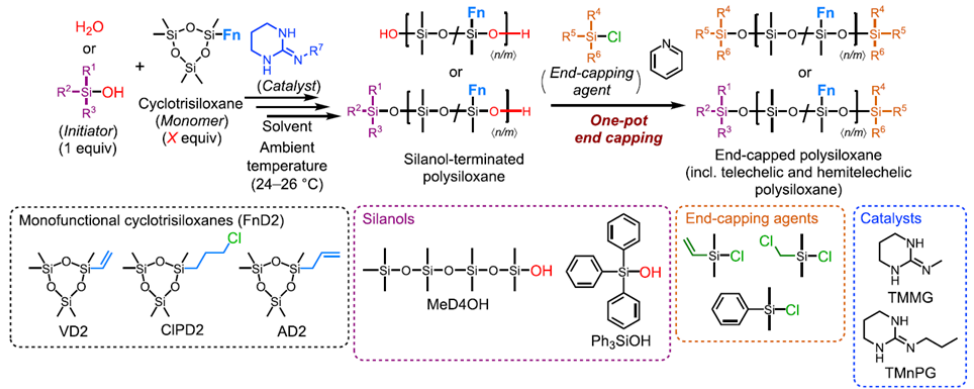
Figure 21. Ring-Opening Polymerization (ROP) of Monofunctional Cyclotrisiloxanes Using Water or Silanols as Initiators and Guanidines as Catalysts (adapted with permission from Ref. [110]. 2021, Fuchise, K.).